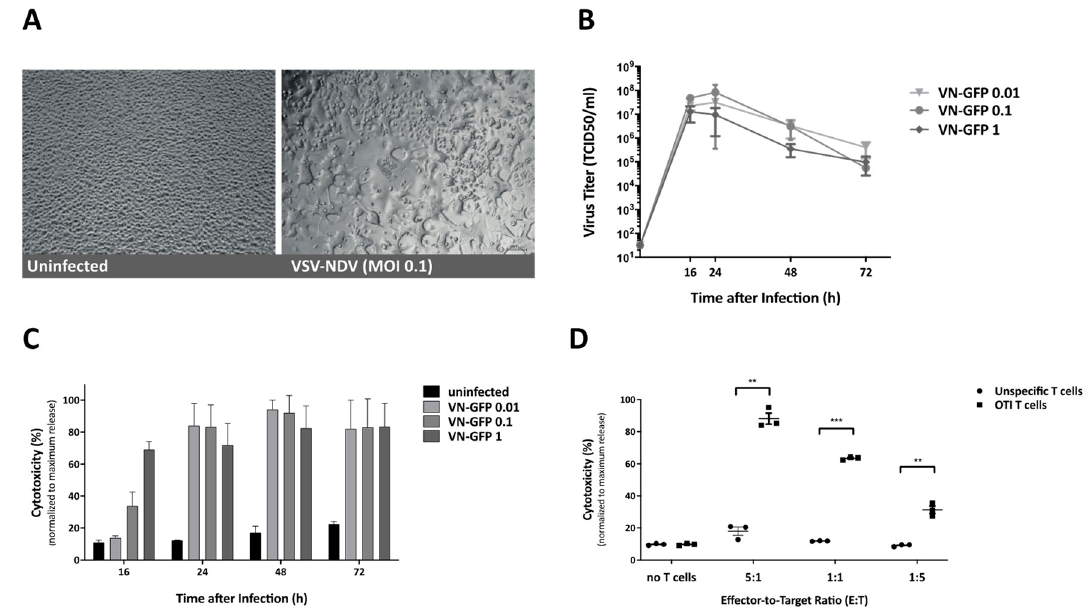
Figure 1. Infection of B16-OVA cells by virotherapy (VSV-NDV) and targeted cytotoxicity by T cells (OTI). ( A ) B16-OVA cells were infected with VSV-NDV at MOI 0.1 (right panel) or left uninfected (left panel), and images were captured 16-h post-infection. Representative images demonstrating characteristic syncytia formation in the infected well and the healthy uninfected monolayer were captured at 200 × magnification. ( B ) B16-OVA cells were seeded and infected with VSV-NDV (VN) at different MOIs. Virus titers were determined via a TCID50 assay from tissue culture supernatants collected at indicated times after infection. ( C ) Corresponding cytotoxicity analysis was determined via an LDH detection assay and normalized to a maximum release control. ( D ) The cytotoxic effector function of OTI T cells on B16-OVA melanoma cells was determined by LDH assay. Cells were co-cultured with OTI or unspecific control T cells for 24 h in the indicated effector-to-target ratios. T cells were isolated from the spleens of OTI or C57Bl6 mice and expanded in vitro before addition to the co-culture. Additional wells of B16-OVA cells were left without the addition of T cells, in order to demonstrate the baseline level of cytotoxicity. All data are presented as mean + SEM of triplicate experiments, and statistical significance was determined by student’s t-test (** p < 0.01, *** p < 0.001).